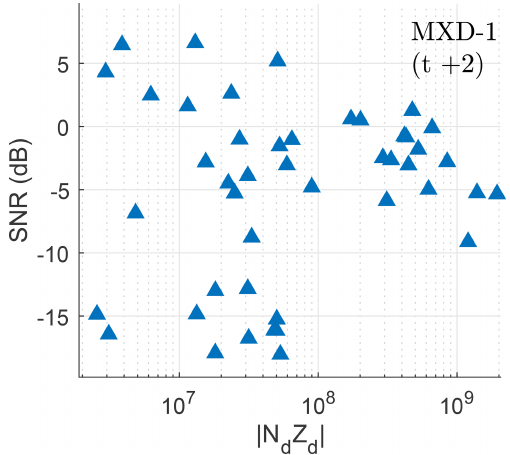
Figure 17. Scatter plot of charge number density derived from DUSTY and PMSE SNR in decibels for the MXD-1 flight. Note that the SNR scale has a range of 3 orders of magnitude; thus a one- to-one correlation would yield a line with a (cid:46) 45 ◦ angle in this plot. No principal axis can be derived significantly for this cluster; i.e. the variance is too